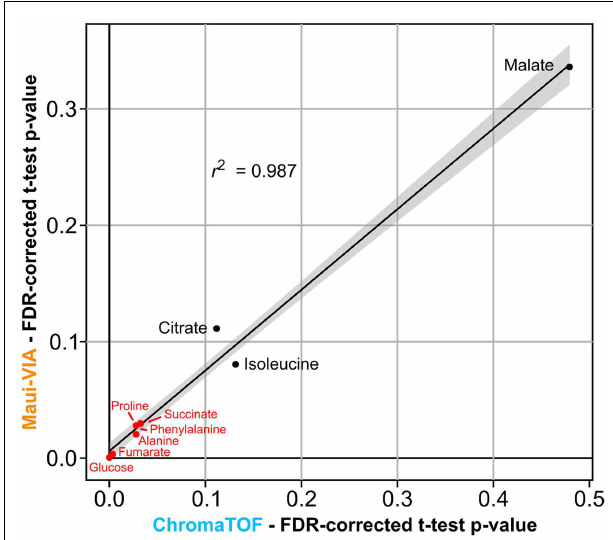
FIGURE 4 | p -values of metabolite differences obtained with Maui-VIA and ChromaTOF strongly correlate . FDR-corrected p- values obtained for each metabolite are plotted for Maui-VIA and ChromaTOF on the y -axis and x -axis, respectively. p- values indicating statistical significance are indicated in red, others in black.The r 2 value of the linear regression displayed is